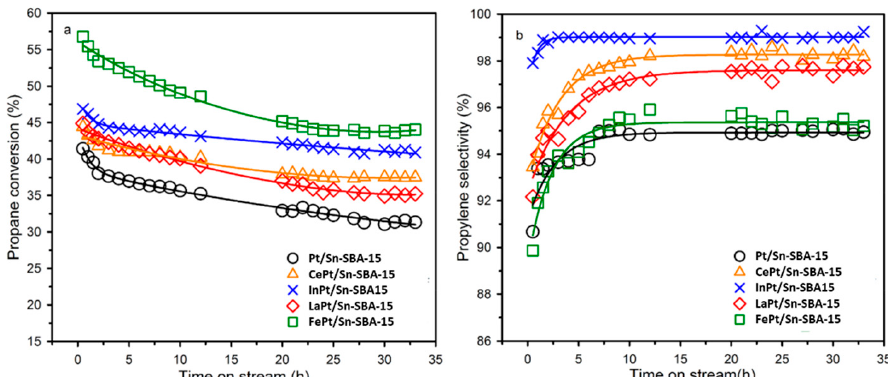
Figure 3. Comparison between the conversion ( a ) and propene selectivity ( b ) of promoted MPt/Sn- SBA-15 (M = Ce, In, La, Fe) (reaction conditions: C 3 H 8 /Ar = 1/4, WHSV = 4.05 h − 1 , 853 K). Reprinted with permission from ref. [34]. Copyright 2019 American Chemical Society .